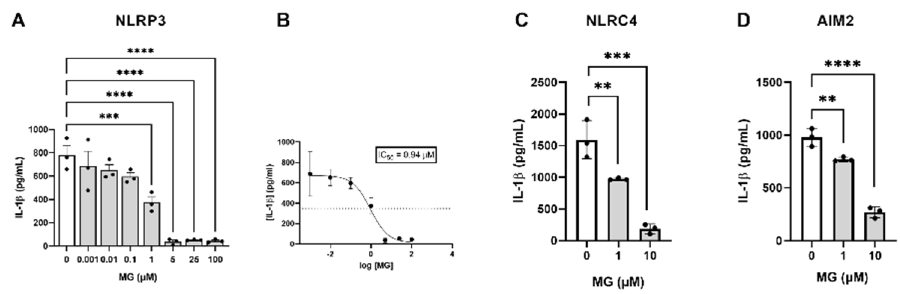
Figure 3. ( A ) Dose-dependent inhibitory effect of MG. ( B ) Dose-response curves for MG. The IC50 value was obtained by nonlinear regression of the data. In both ( A ) and ( B ), primary murine microglia cultures were treated with increased MG concentrations prior to NLRP3 activation with LPS and ATP. ( C ) Inhibitory effect of MG on the NLRC4 inflammasome. Primary microglia cells were pre-treated with MG, and then NLRC4 specific activation was induced with LPS followed by treatment with flagellin. ( D ) Inhibition of the AIM-2 inflammasome by MG. Murine primary microglia were treated with MG before AIM-2 priming and activation with LPS and poly (dA:dT). In all panels, the inhibition of inflammasome pathways by MG was determined by measuring the IL-1 β concentration in culture supernatants through ELISA. All the experiments were conducted in triplicate, and samples were run in technical replicates. Statistical significances are referred to control samples (cells pre-treated with the same DMSO% and concentration of the corresponding inflammasome activators). All graphs represent mean ± s.e.m. Scatter plots represent individual values depicted as black dots. Significance levels, as calculated by one-way analysis of variance, are indicated as ( A ) 0 µM vs. 1 µM: *** p = 0.0999; 0 µM vs. 5 µM: **** p < 0.0001; 0 µM vs. 25 µM: **** p < 0.0001; 0 µM vs. 100 µM: **** p < 0.0001. ( C ) 0 µM vs. 1 µM: ** p = 0.0094; 0 µM vs. 10 µM: *** p = 0.001; ( D ) 0 µM vs.